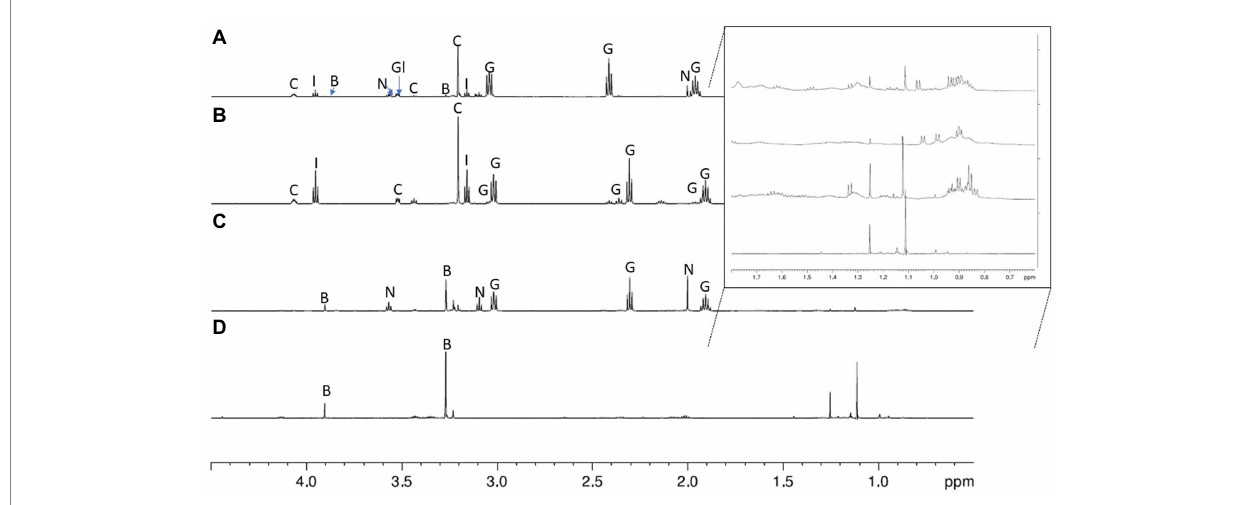
FIGURE 2 600 MHz 1 H NMR spectra of glues from (from top to bottom): Argiope keyserlingi (A) , Latrodectus hasselti (B) , Steatoda grossa (C) , and Pholcus phalangioides (D) across the spectral range 0 to 5 ppm, with the 0.5 to 2.0 ppm spectral range enhanced as an inset. See the ‘Materials and Methods’ section for details about NMR preparation and data acquisition. Annotations on the spectra are: C, choline; B, betaine; I, isethionic acid; G, GABA/ GABAmide; N, N-acetyltaurine; Gl,